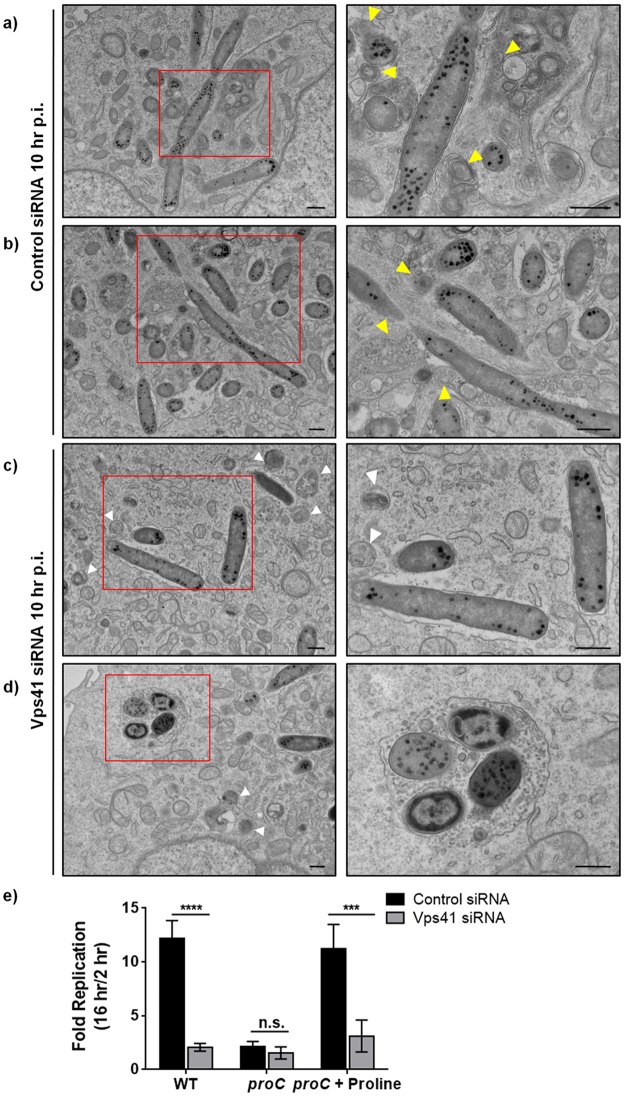
Silencing of Vps41 abrogates docking of late endosomes and lysosomes at SCVs and impairs nutrient acquisition by auxotrophic strain of Salmonella.a-d) Representative TEM images of control (a and b) and Vps41 (c and d) siRNA treated HeLa cells infected with Salmonella for 10 hr. Higher magnification of multiple SCVs (marked by yellow arrowheads) interacting with late endosomes (containing MVBs) and lysosomes (containing lamellar membrane sheets) in control siRNA treated cells are shown in the panels on the right. In Vps41 siRNA treated cells, white arrowheads depict the MVBs containing late endosomal compartments. Bar: 500 nm. e) Intracellular replication of wild-type (WT) Salmonella and a mutant strain auxotrophic for proline (proC) was determined at indicated times p.i. in control siRNA- or Vps41 siRNA-transfected HeLa cells. The fold change in intracellular proliferation was calculated as the ratio of CFU at 16 hr p.i./CFU at 2 hr p.i. To complement the intracellular proliferation of proC Salmonella strain, cell culture medium was supplemented with proline (0.8 mM). Shown are the means ± S.D. from three independent experiments (n.s., not significant; ***, P < 0.001; ****, P < 0.0001; Student’s t test).